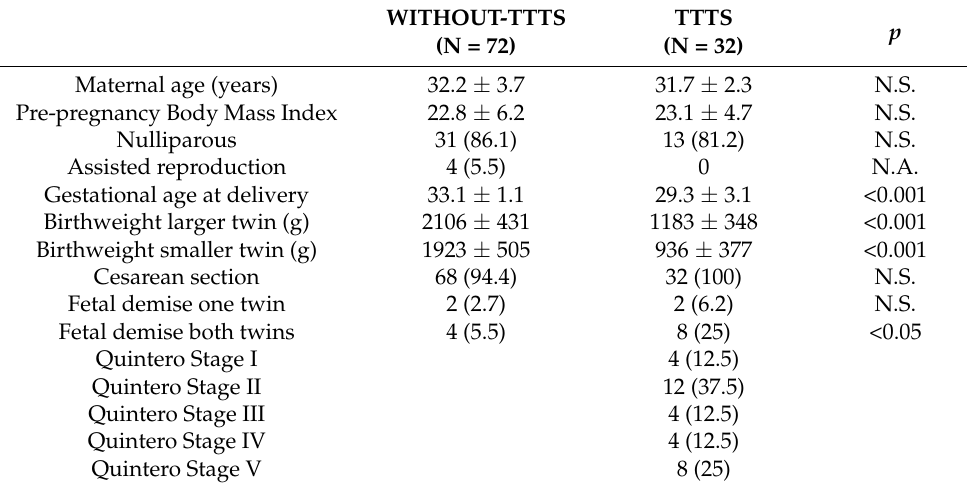
Table 1. Characteristics of study groups.